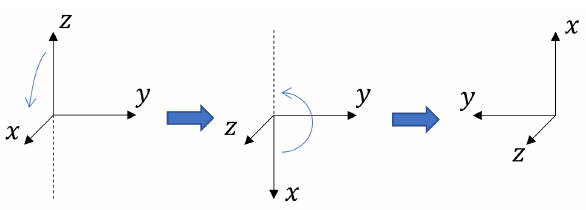
FIG. 9. Rotational decomposition of the Hadamard